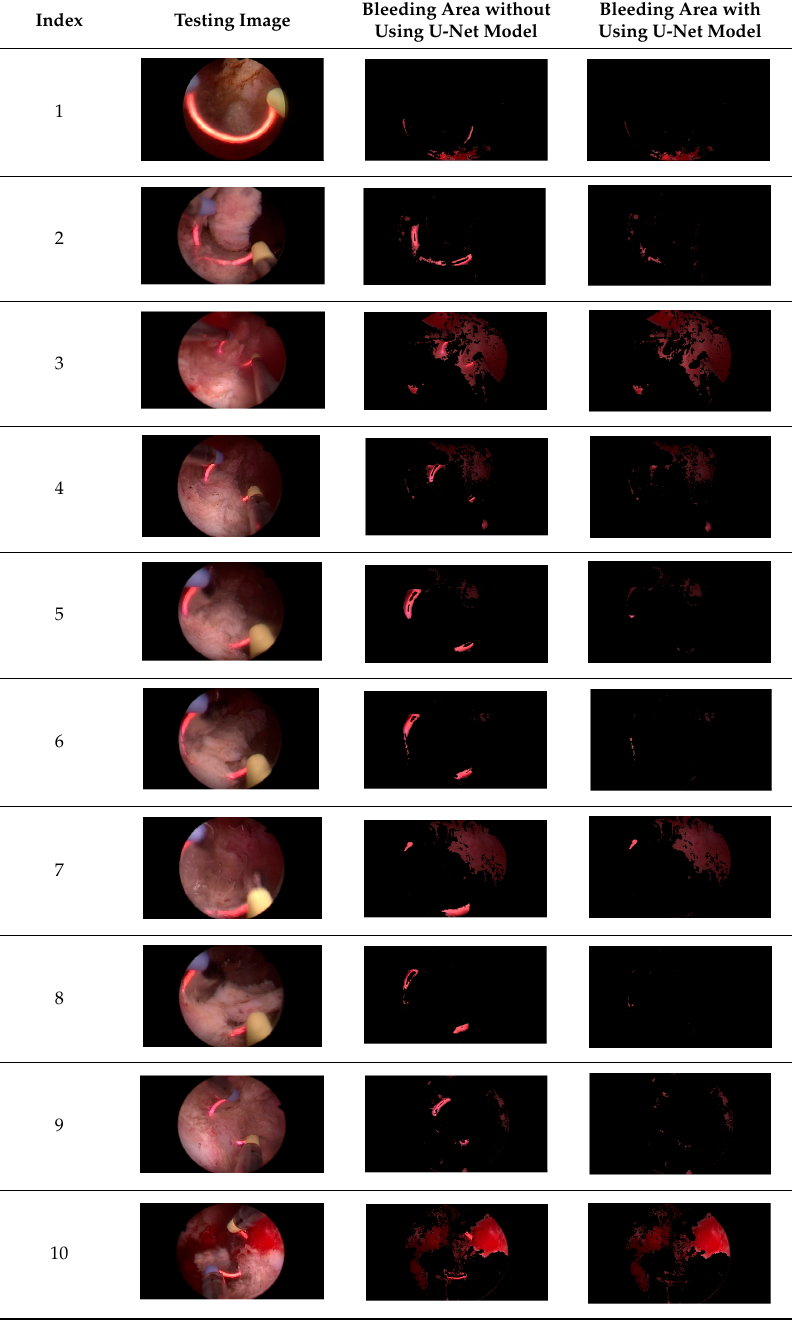
Table 10. The comparison of the mean residual coe ffi cient score with di ff erent